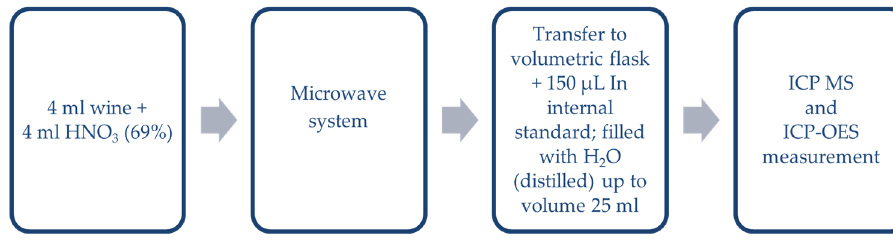
Figure 1. Procedure of sample preparation.